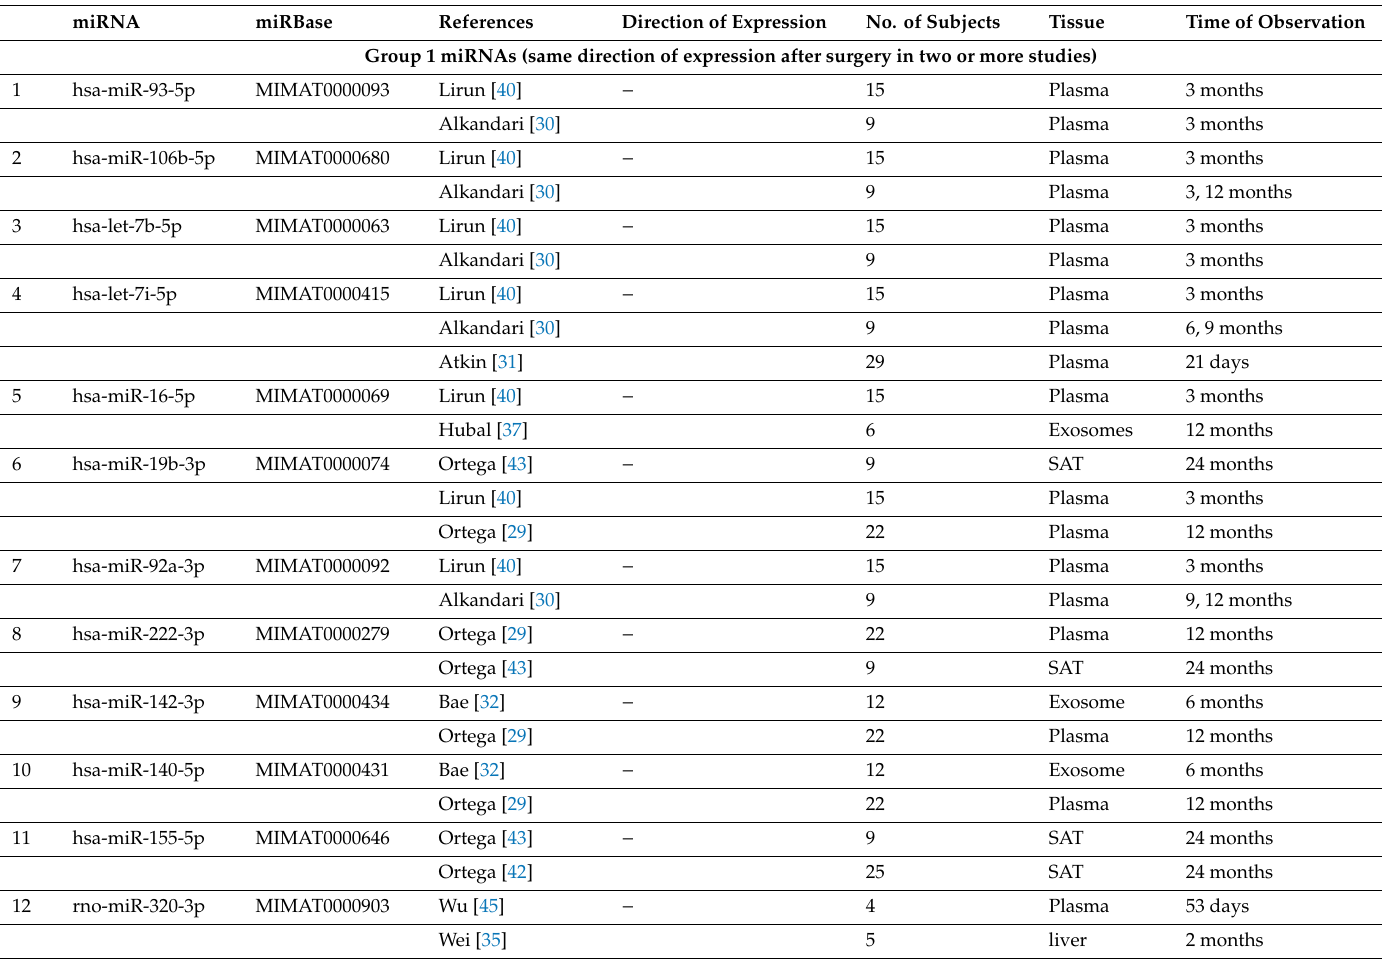
Table 4. Di ff erentially expressed miRNA before vs after surgery reported in at least two studies. miRNA miRBase References Direction of Expression No. of Subjects Tissue Time of Observation Group 1 miRNAs (same direction of expression after surgery in two or more